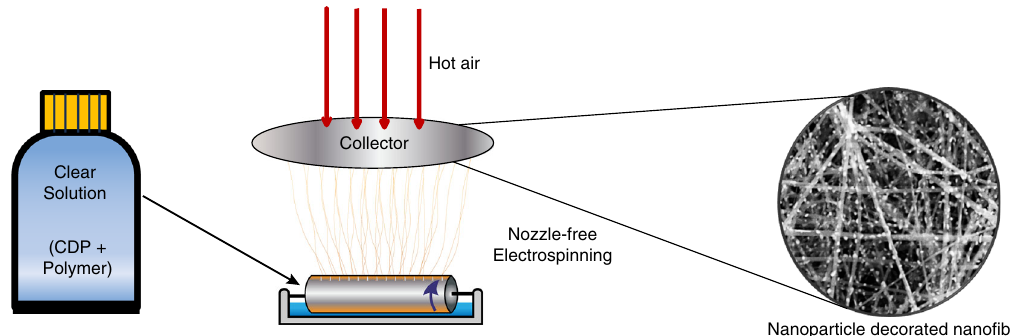
Fig. 1 Schematic illustration of the electrospinning process. The nanoparticle-decorated nano fi bres are fabricated from a clear solution in a single step, containing dissolved caesium dihydrogen phosphate (CDP) and polymers. Multiple Taylor cones form on the rotating electrode immersed into the solution. Hot air is blown on the collector electrode, enabling electrospinning to take place at low polymer concentrations. Uniform fi bres with CDP nanoparticles are